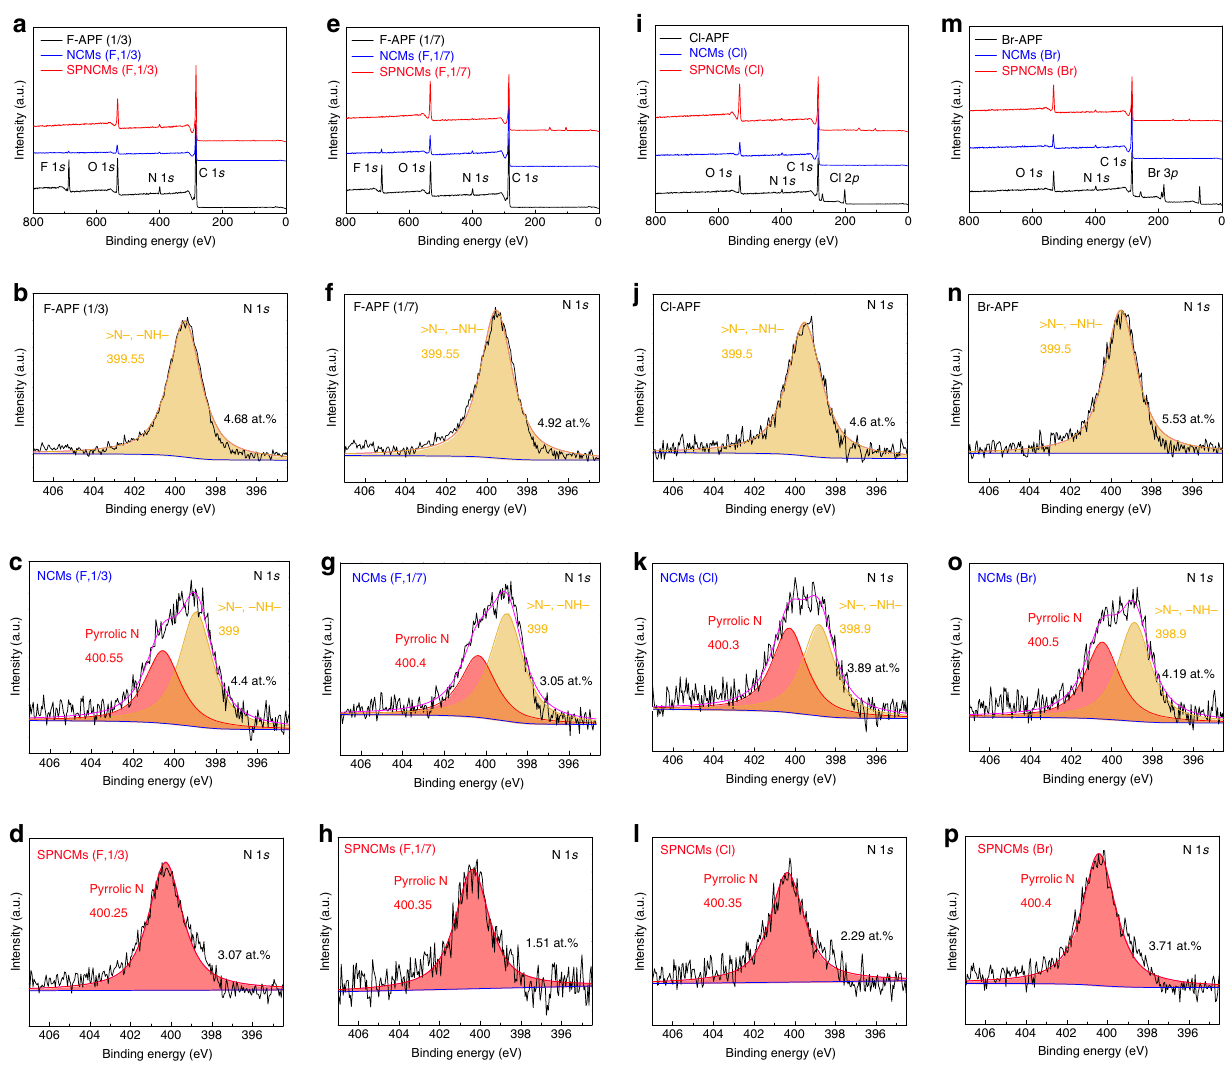
Fig. 3 XPS spectra of the samples. a , e , i , m XPS survey spectra of samples. High-resolution N 1 s XPS spectra for b the F-APF resin (1/3), c NCMs (F, 1/3), d SPNCMs (F, 1/3), f F-APF resin (1/7), g NCMs (F, 1/7), h SPNCMs (F, 1/7), j F-APF resin (Cl), k NCMs (Cl), l SPNCMs (Cl), n F-APF resin (Br), o NCMs (Br), and p SPNCMs